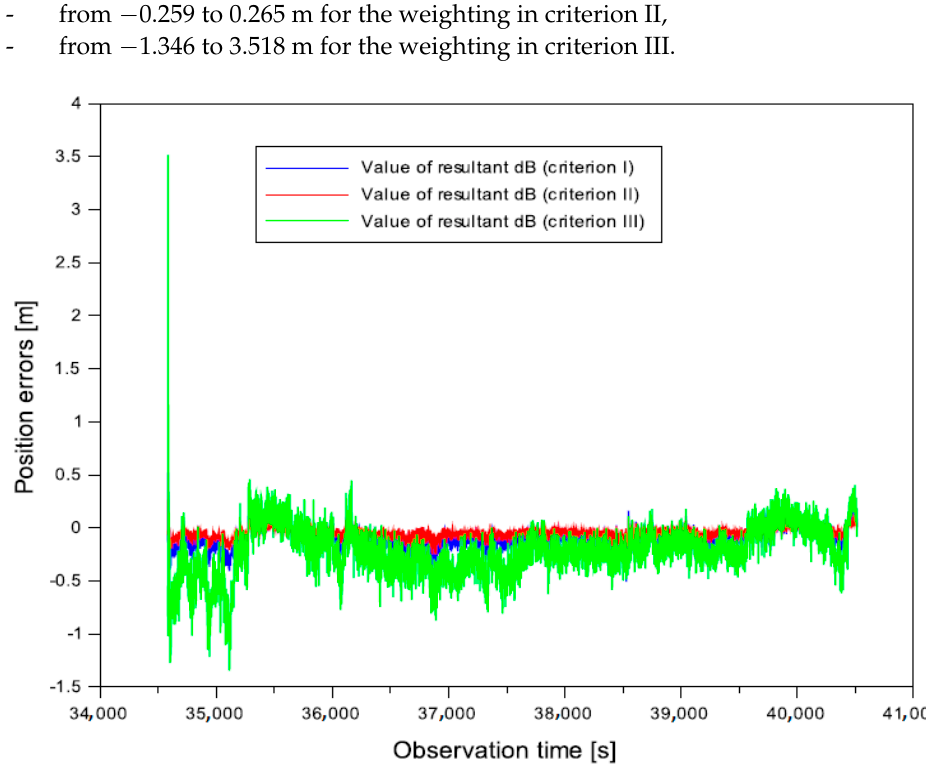
Figure 9. The values of resultant position errors dB .